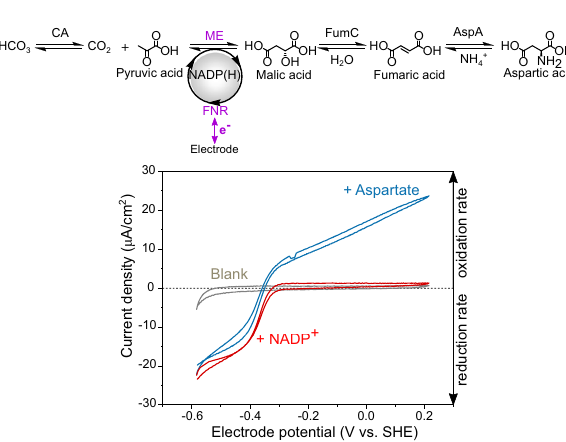
Electrode potential (V vs. SHE) Fig. 2 Cyclic voltammetry of an extended enzyme cascade trapped in electrode nanopores. a Scheme of the nanocon fi ned cascade driving reductive amination/carboxylation of pyruvate to aspartate in either direction through bidirectional electrocatalytic recycling of NADP(H) by the transducer enzyme FNR. CA carbonic anhydrase; FNR ferredoxin- NADP + -reductase; ME malic enzyme; FumC fumarase; AspA aspartate- amino-lyase. b Cyclic voltammetry (25 °C, pH 7.5, 1 mV s − 1 ) of the 5- enzyme cascade (0.1 CA/1 FNR/5 ME/1 FumC/1 AspA) in buffer 0.05 M HEPES, 20 mM pyruvate, 0.1 M KHCO 3 , 0.1 M NH 4 Cl, 4 mM MgCl 2 , 1 mM MnCl 2 . Gray: blank, no cofactor present. Red: injection of NADP + (to 20 µ M). Blue: injection of aspartate (to 20